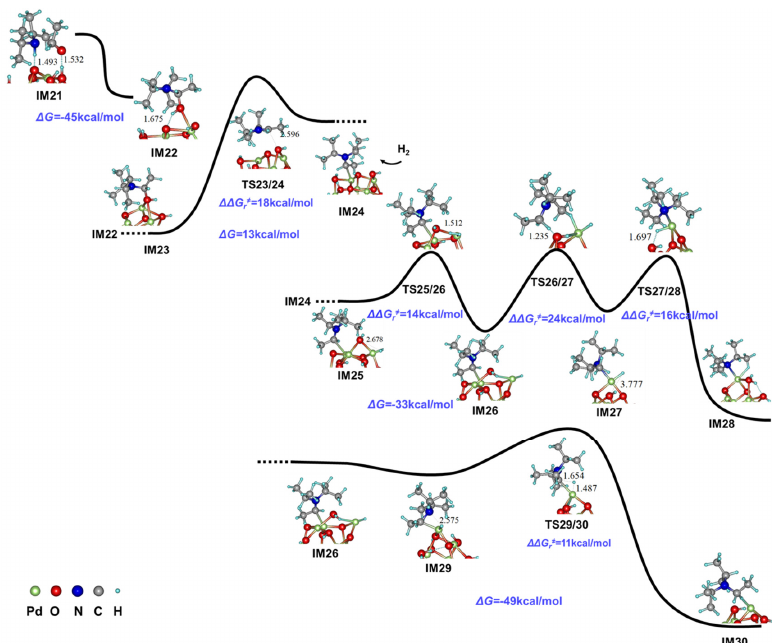
Figure 7. Simplified PES and selected structural information of alternative pathways for the generation of N,N-Diisopropylethylamine mediated by the Pd 8 O 12 H 8 cluster.